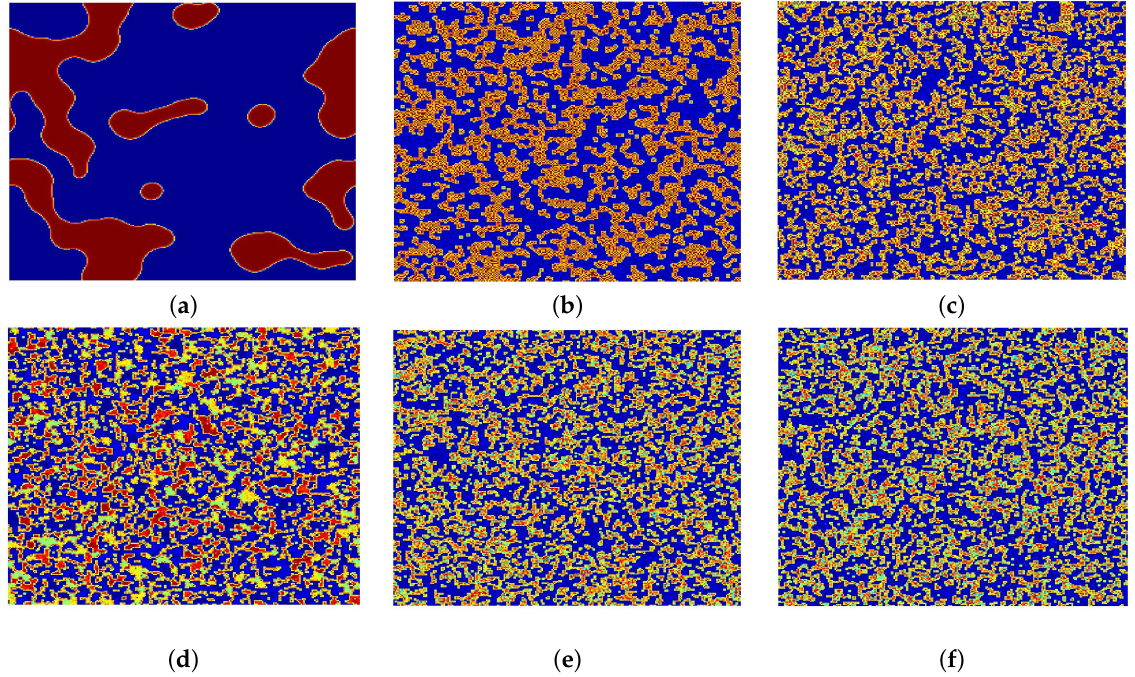
Figure 6. The patterns for flip-Turing instability. ( a ) τ = 3.6; ( b ) τ = 3.8; ( c ) τ = 3.96; ( d ) τ = 4.02; ( e ) τ = 4.12; ( f ) τ =